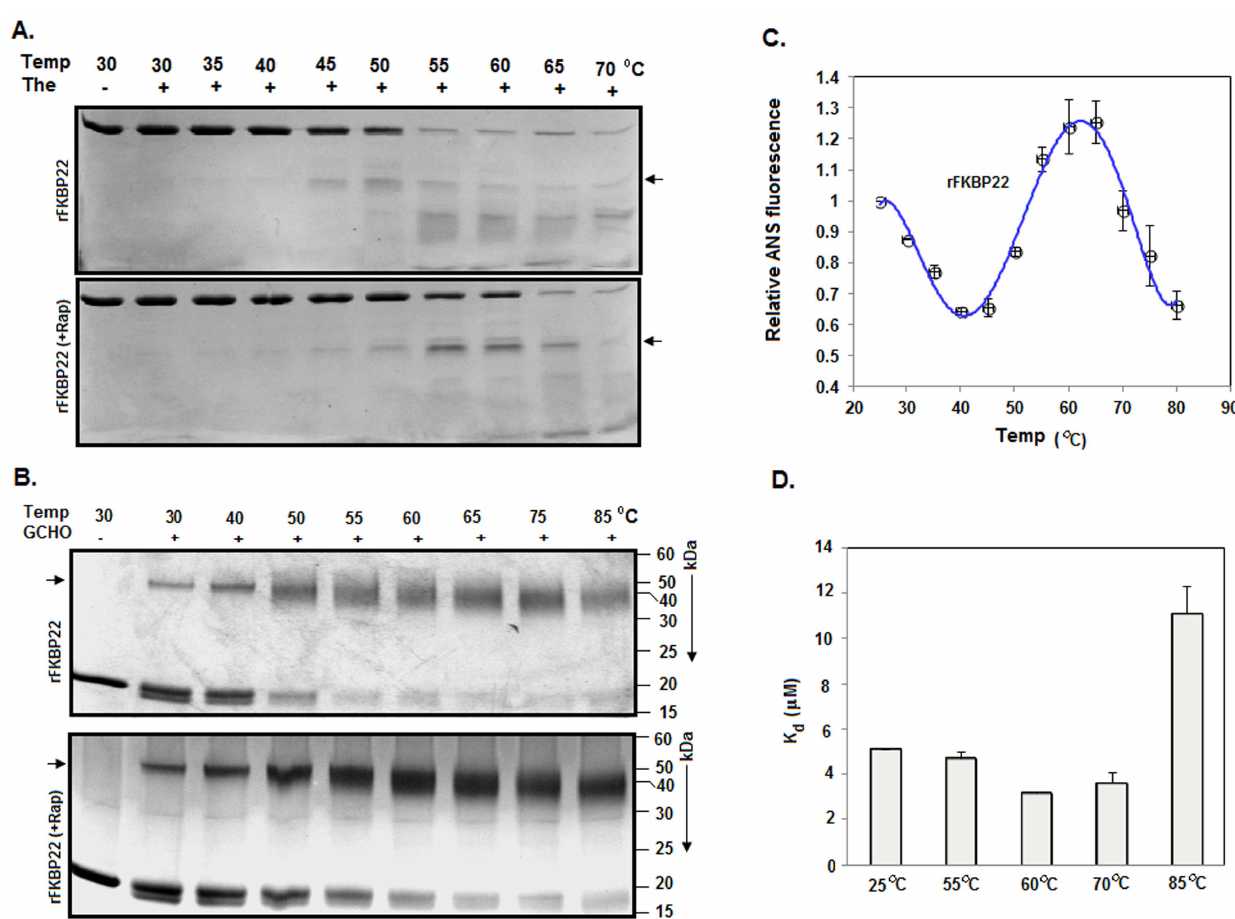
Figure 6. Characterization of the intermediates. (A) SDS-13.5% PAGE analysis of the fragments obtained from partial proteolysis of rFKBP22 (attached with or without rapamycin) with thermolysin (The) at 30 u –70 u C. Arrow indicates the additional protein fragments produced during proteolysis. (B) Chemical cross-linking. Proteins generated from glutaraldehyde (GCHO)-mediated cross-linking of rFKBP22 (attached with or without rFKBP22) at 30 u –70 u C were analyzed by SDS-13.5% PAGE. Arrow indicates dimeric rFKBP22 (attached with or without rapamycin). (C) ANS fluorescence of rFKBP22 at different temperatures. (D) Determination of K d values for rapamycin-rFKBP22 interactions at different temperatures.